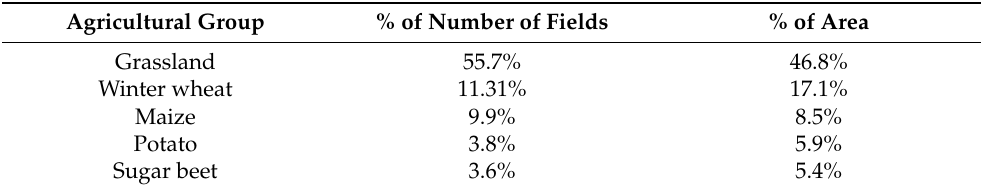
Table 1. Most represented agricultural groups, with their relative appearance in terms of number of fields and of